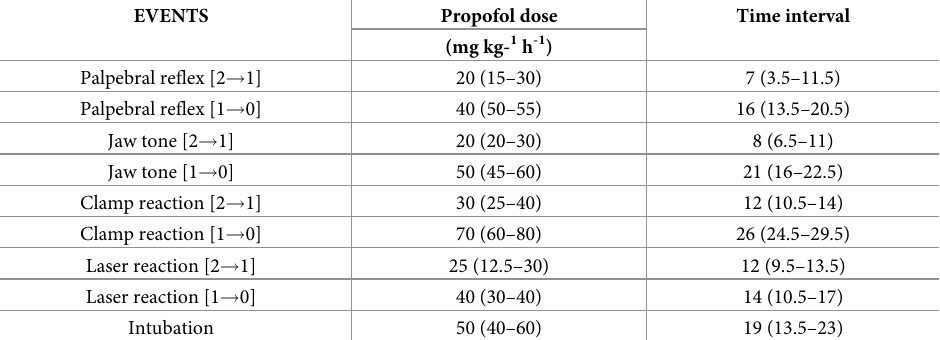
Table 1. Median (interquartile ranges) of propofol doses (in mg kg -1 h -1 ) and time intervals at which the different clinical outcome scores changed (in square brackets) and intubation was performed.